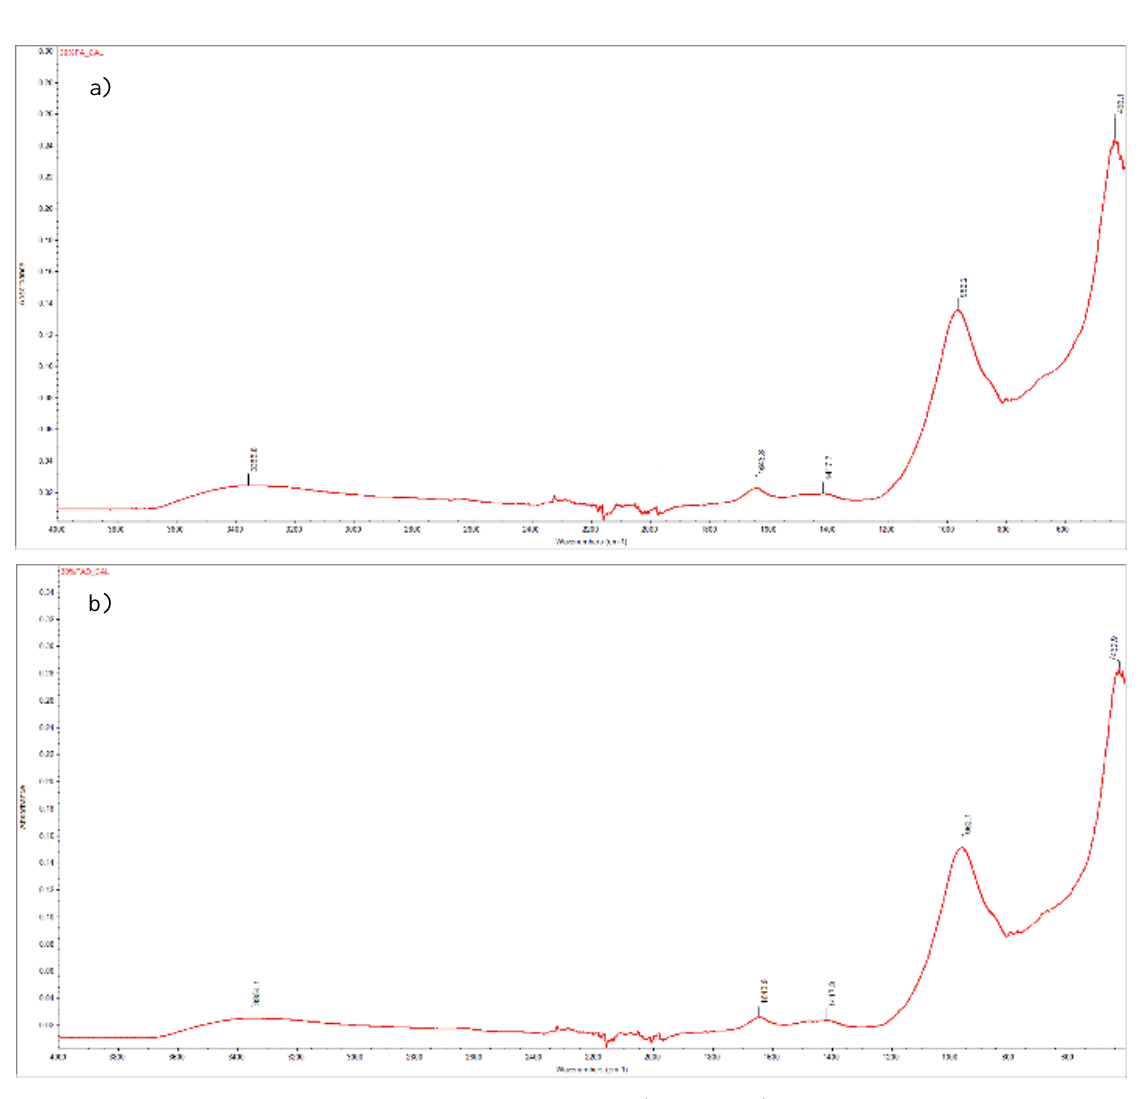
Figure 5. The result of FTIR using a) 20 % FA b) 20 % FAD.